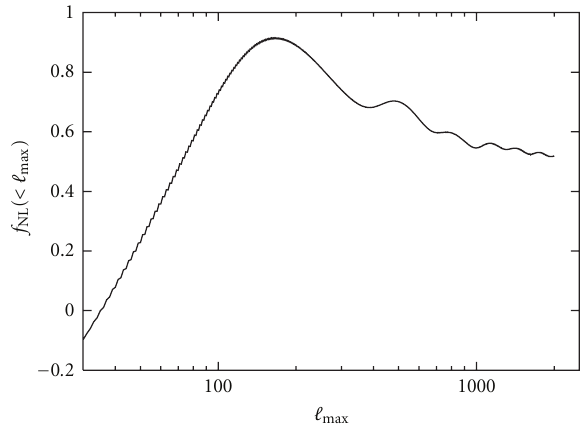
Figure 5: Contamination of the local primordial bispectrum as (359). measured by f con NL